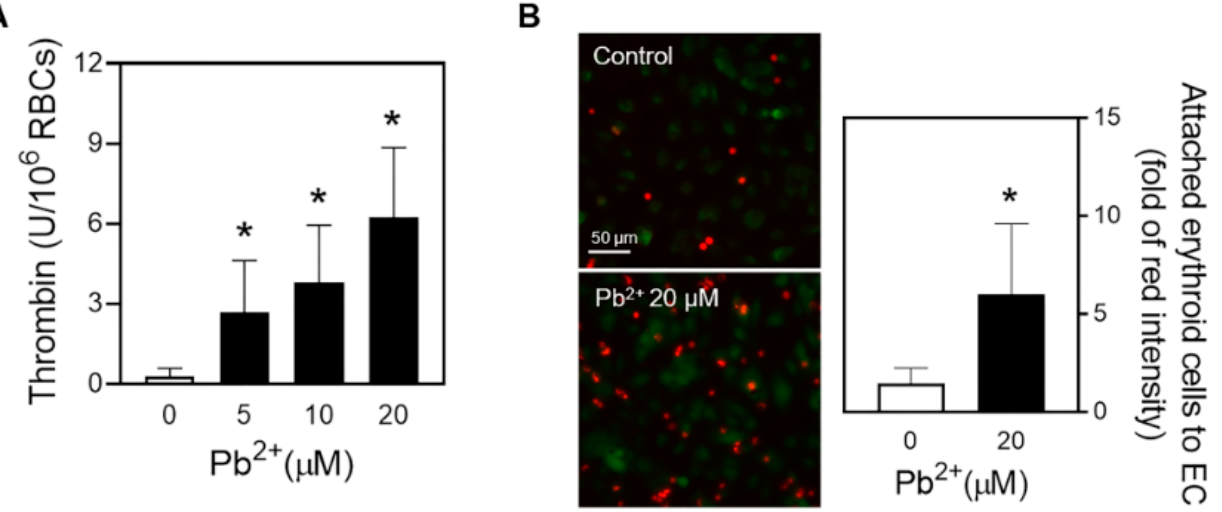
Figure 4. Pb-induced eryptosis participated in procoagulant activity and adhesion to endothelium cells. After isolated human erythroid cells were treated with distilled water (DW; control) or various concentrations of Pb for 1 h at 37 ◦ C, ( A ) procoagulant activity was shown by a concentration- dependent trend of thrombin generation using prothrombinase assay ( n = 4–7). ( B ) Enhanced adherent erythroid cells to HUVECs were detected by fluorescence microscope as described in the Materials and Methods section. Endothelial cells (green fluorescence); erythroid cells (red fluorescence) ( n = 4). Values are the mean ± SD of 4–7 experiments. * Statistical difference compared with control ( p < 0.05). Scale bars ( B ): 50 μ m.